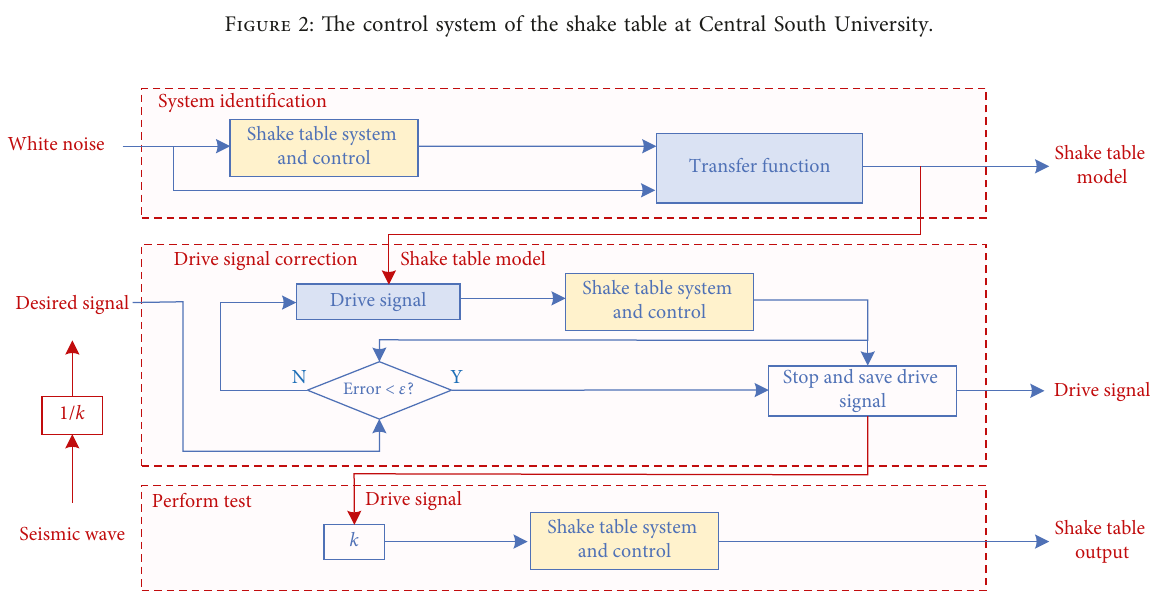
Figure 3: Flow diagram of